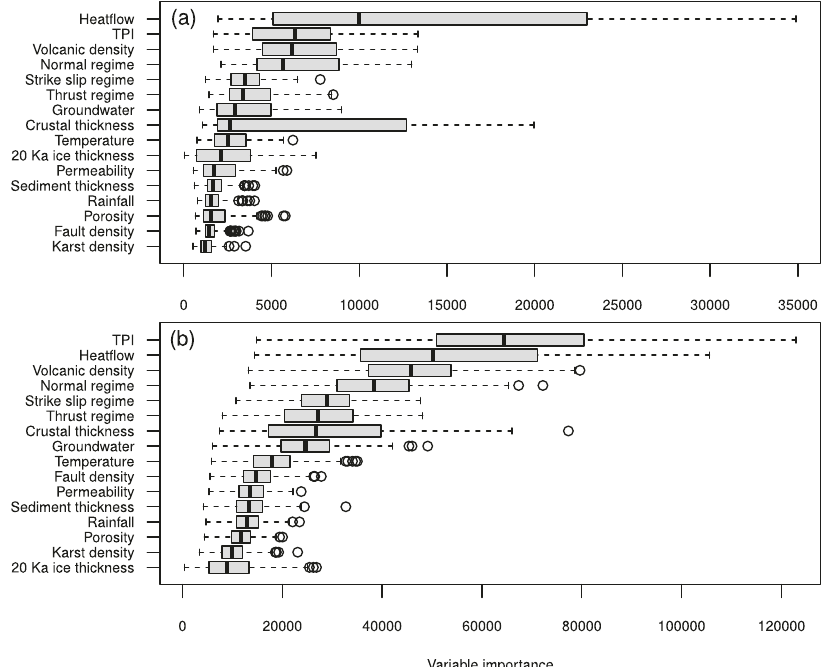
Fig. 6 | Geologicalfactorsimportanceinthermalsprings. Boxplots of variableimportanceresulting from the Random Forest algorithm run on 500randomlysampled data sets to predict the ( a ) number of geothermal spring areas and b number of thermal springs.